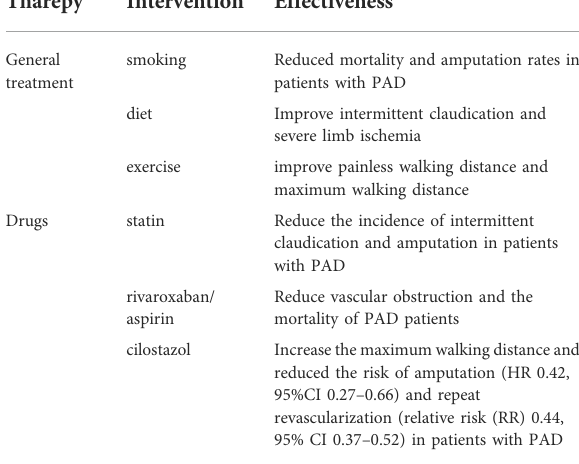
TABLE 1 Summary of PAD treatment. Tharepy Intervention